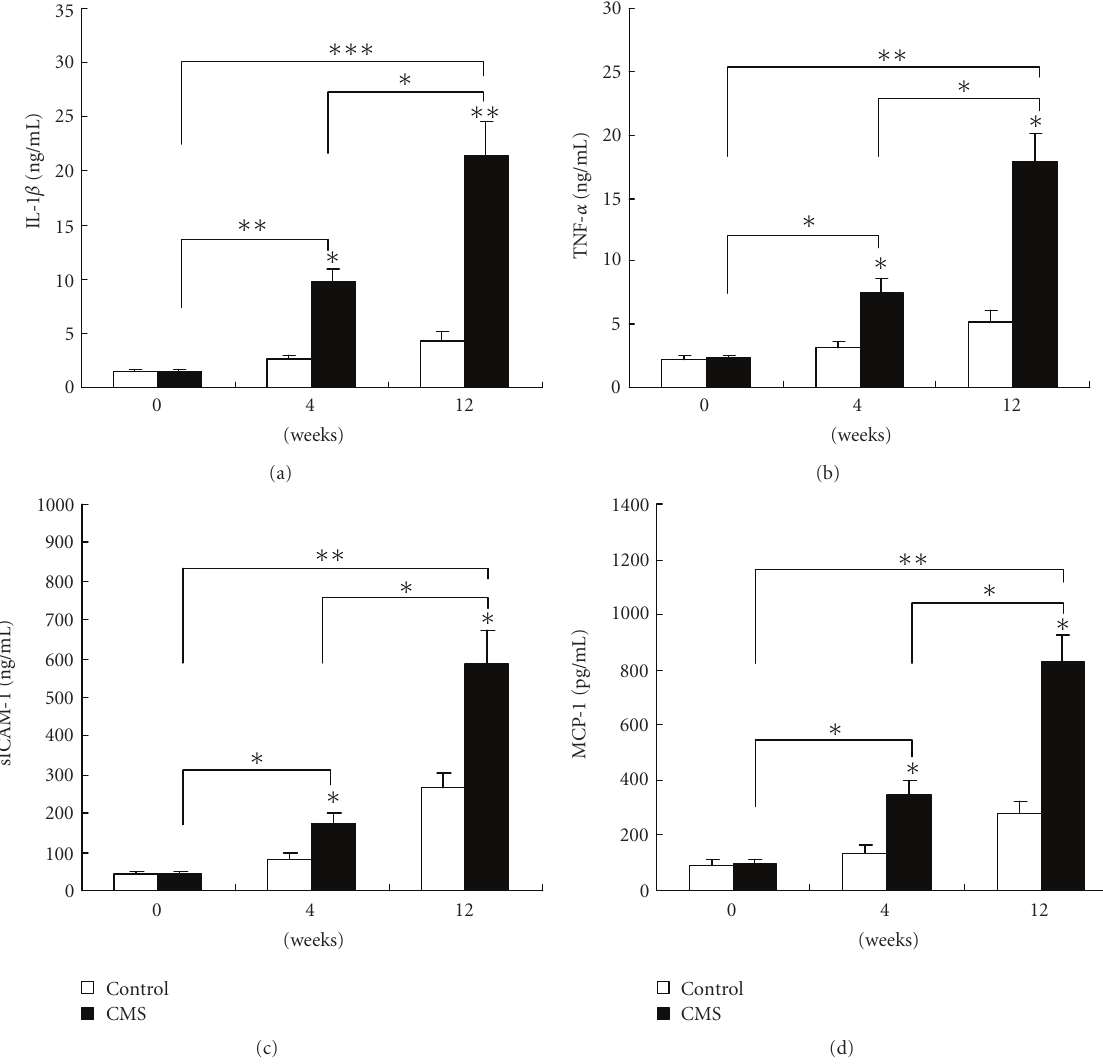
Figure 8: MCP-1, sICAM-1, and TNF-a levels in the serum of apoE-/- mice were analyzed by ELISA. IL-1 β (a), TNF-a (b), sICAM-1 (c), and MCP-1 (d) levels markedly increased in the serum of apoE mice following di ff erent weeks of CMS compared with the corresponding control group ( n = 20 per group). These cytokines were measured by ELISA according to the manufacturer’s instructions. Data are mean ± SEM. ∗ P < . 05, ∗∗ P < . 01, ∗∗∗ P < . 01 versus respective control value.